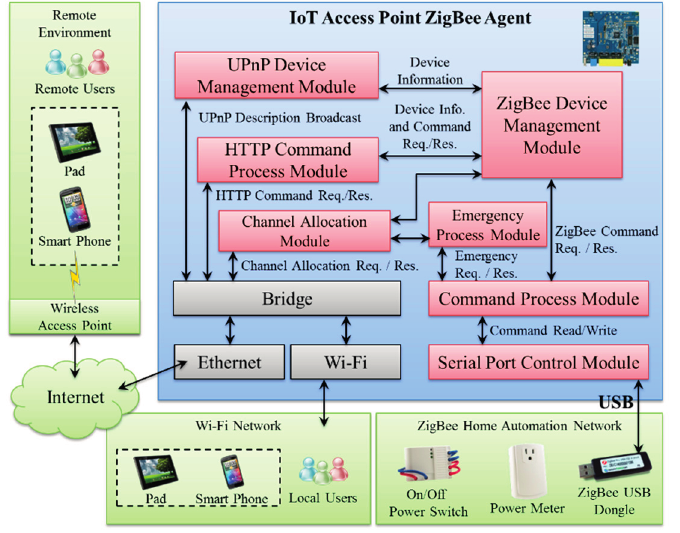
Figure 2. The system architecture of the proposed IoT